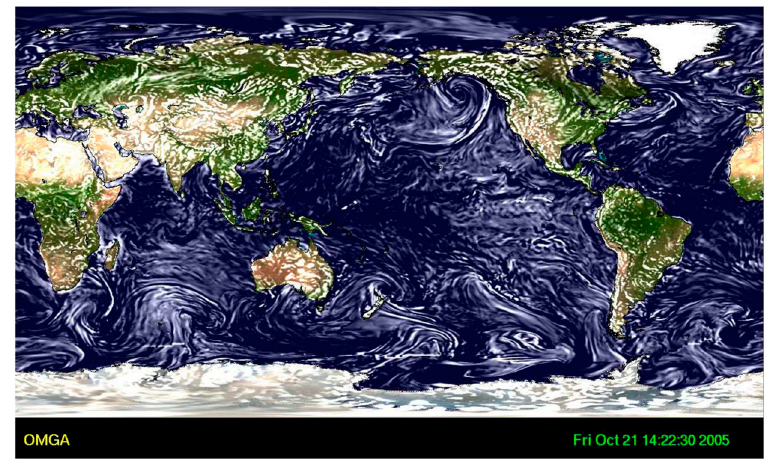
Figure 6. A selected frame from a global animation of the vertical velocity in pressure coordinates from a run initialized at 0000 UTC 21 October 2005. The corresponding animation is available as a google document: http: // bit.ly / 2GS2flD. The animation displays dissipation of the initial noise associated with an imbalance between the model and the initial